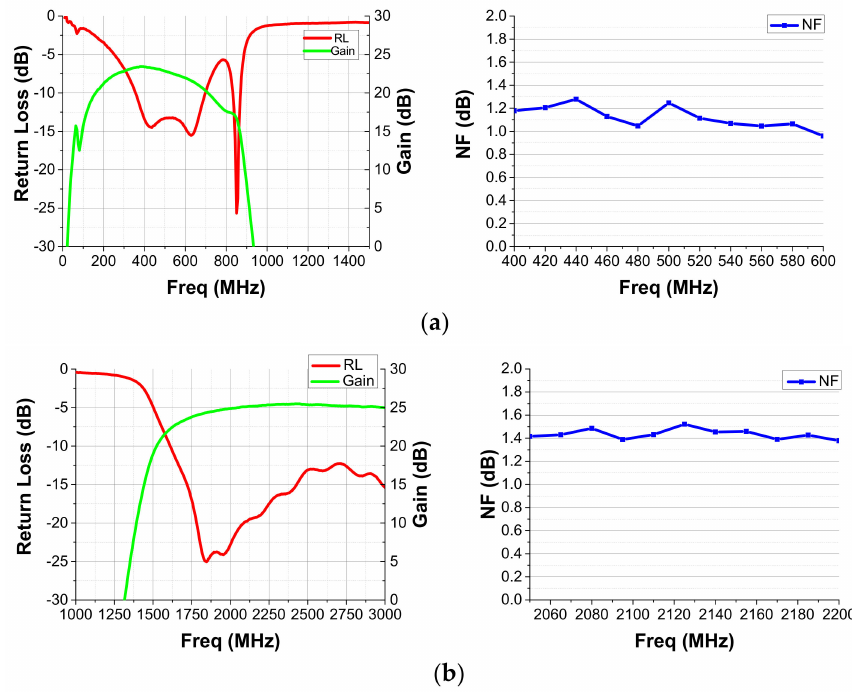
Figure 17. Measured results of the double stacked 3DHI RF front-end module. ( a ) Test result of channel 1, ( b ) test result of channel 2.